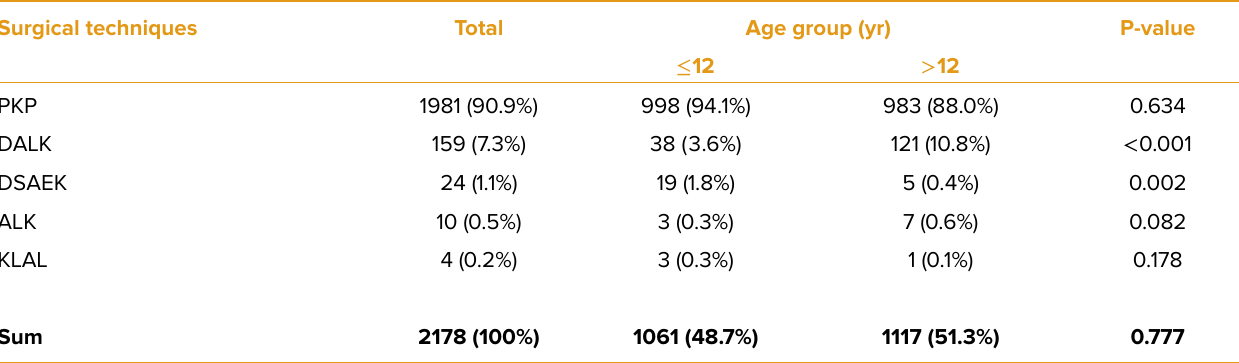
Table 2. Number of surgical techniques used for pediatric keratoplasty between 2006 and 2019, and the corresponding distribution in two age groups of ≤ 12 and > 12 years.